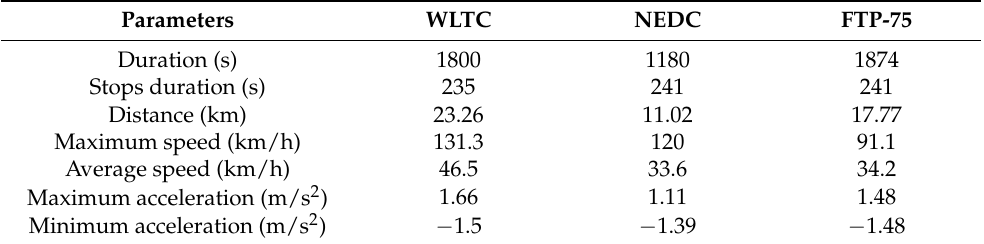
Table 2. Vehicle test